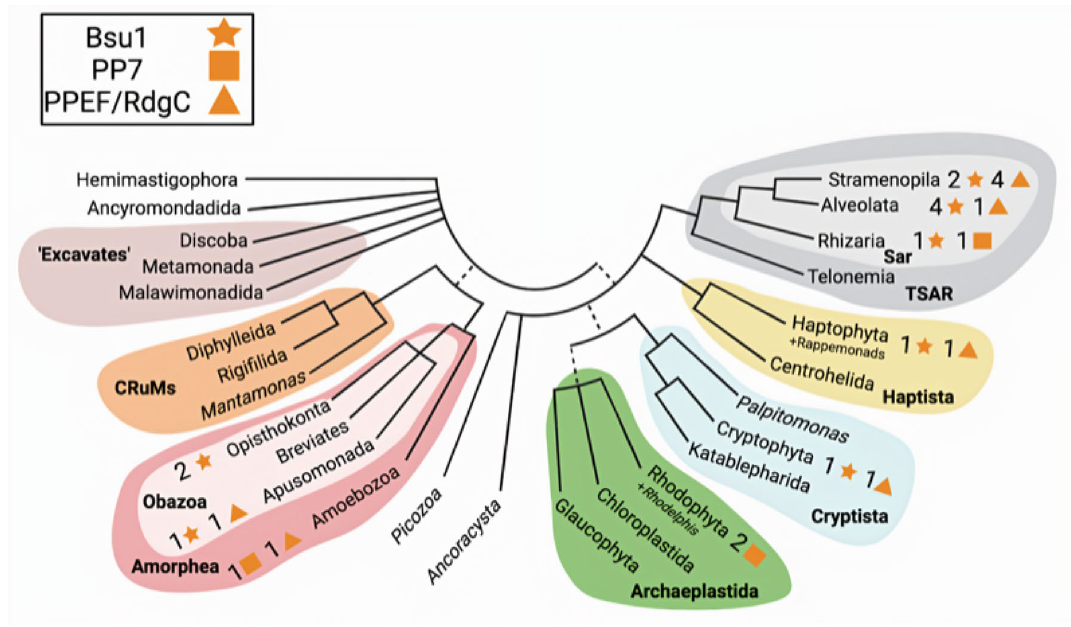
Figure 5. Eukaryotic PPP subtype sequences mapped onto the current Eukaryotic tree of life. Candidate novel sequences for eukaryotic PPP (phosphoprotein phosphatase) subtypes were collected from an iterative database search utilizing eukaryotic PPP HMMs as detailed in “Methods”. Candidates were validated by sequence alignment and phylogenetic tree inference, as detailed in “Methods”. The alignment of these validated sequences, together with reference eukaryotic PPPs, is presented as Supplemental Figure S12. The phylogenetic trees encompassing these sequences are presented as Supplemental Figure S10 (Maximum Likelihood) and Supplemental Figure S11 (rooted Bayesian). The Eukaryotic tree of life was modelled after the tree present in 12 . The number of newly identified sequences for Bsu1 (star), PP7 (square) and PPEF/RdgC (triangle) are indicated. Major organismal groups where the sequences are found is detail in Supplemental Figure S14. Image was created using BioRender